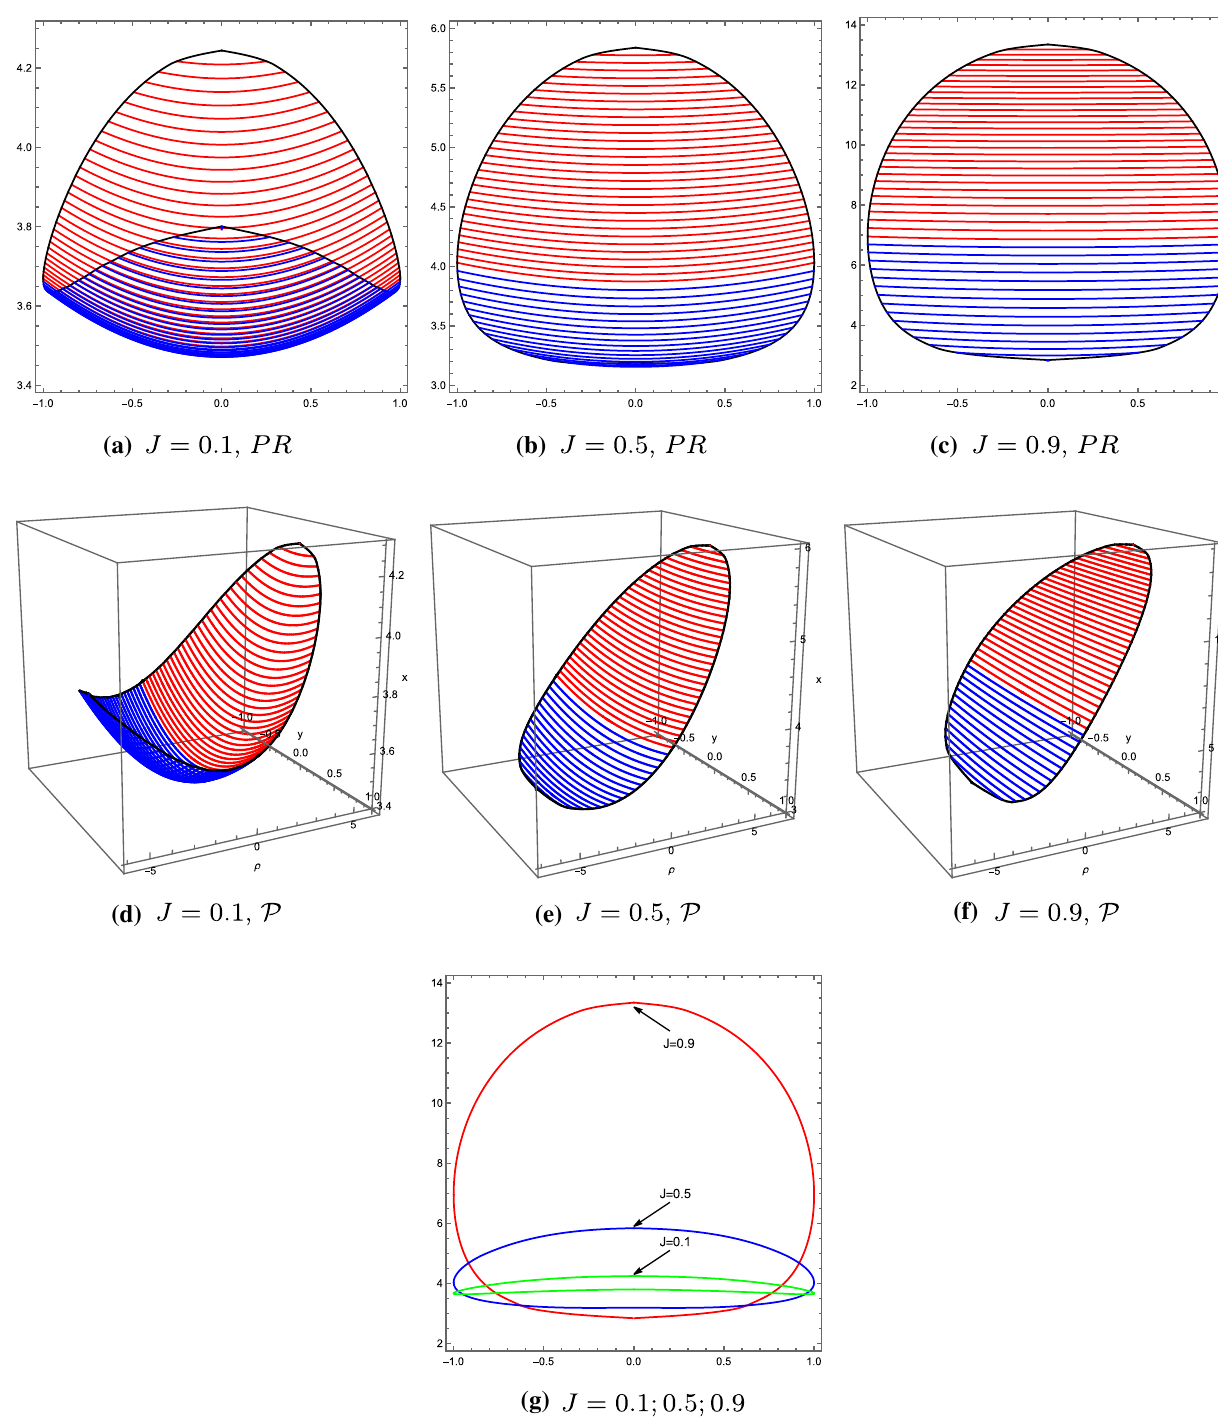
Fig. 4 PR and P in Tomimatsu-Sato metric ( M = 1, J = 0 . 1 ; 0 . 5 ; 0 .